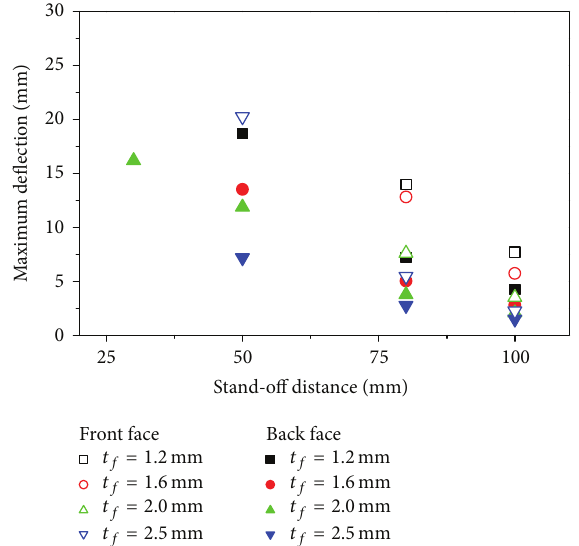
Figure 16: Maximum deflections of sandwich panels with same core configuration ( 𝑡 𝑐 = 1.0 mm, 𝑙 = 20 mm).